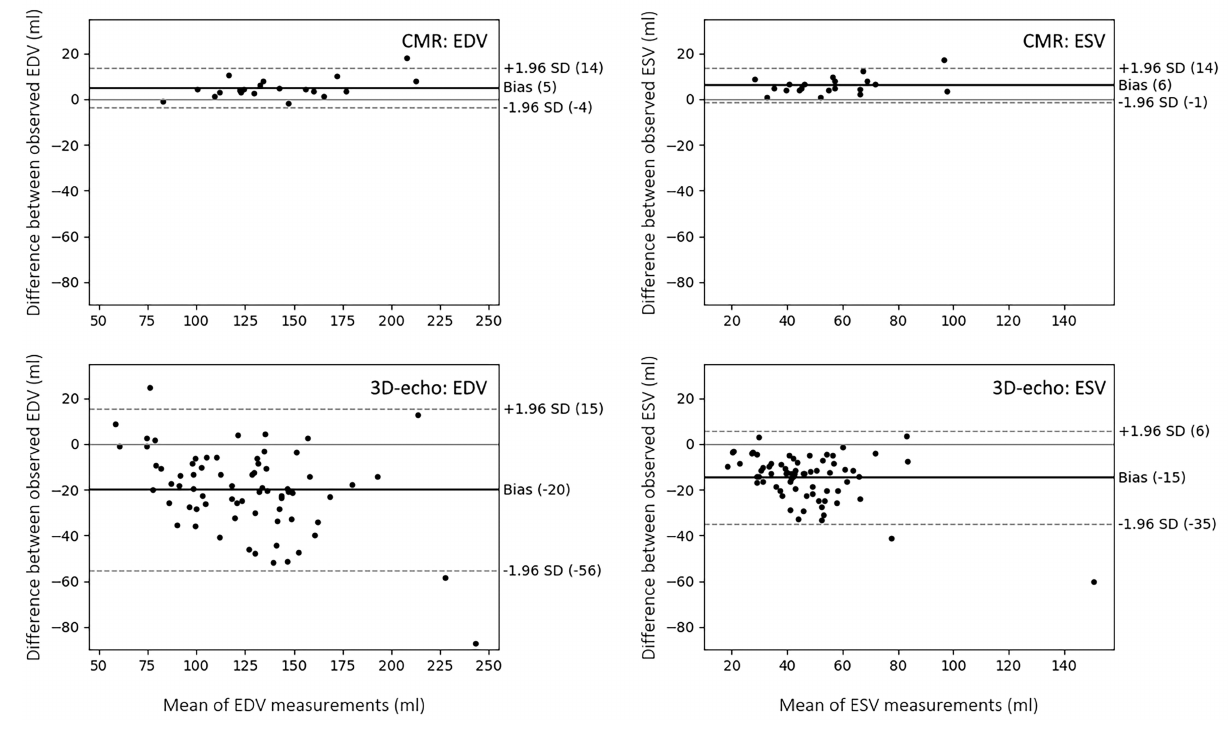
Frontiers in Cardiovascular Medicine |